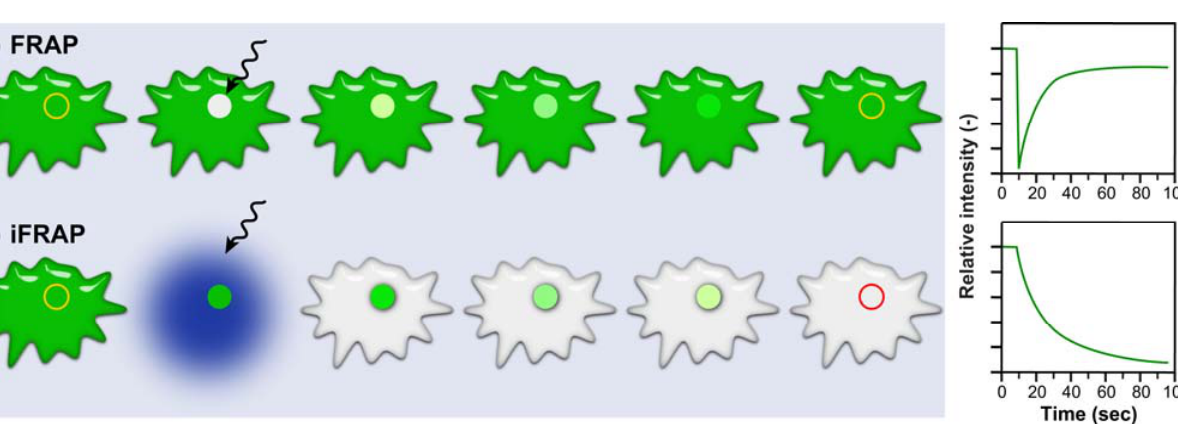
Figure 11. Schematic representation of a FRAP and iFRAP experiment. ( A ) A region of interest (ROI) is selected, bleached with an intense laser beam, and the fluorescence recovery in the ROI is measured over time. ( B ) In iFRAP, the reverse is done and a ROI is selected to remain intact, while the rest of the cell is bleached. This is particularly useful when studying dynamic movement in organelles such as the